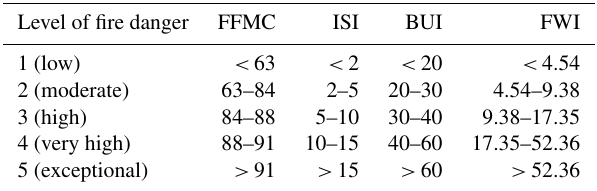
Table 1. Fire danger classes used by the Met Office for the UK (in particular England and